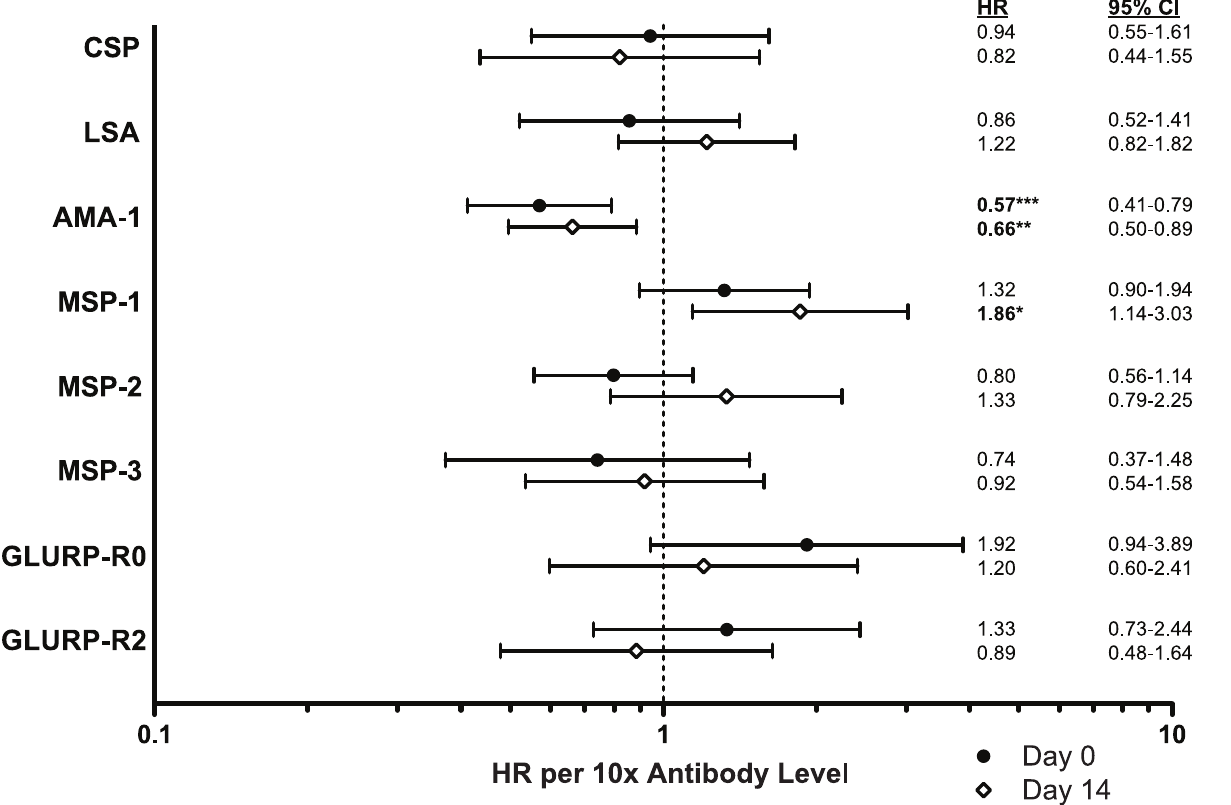
Figure 2. IgG responses and protection against treatment failure with amodiaquine + sulfadoxine-pyrimethamine (AQ + SP). Associations between IgG responses to 8 Plasmodium falciparum antigens and protection against treatment failure with AQ + SP were examined. Hazard ratios (HR), depicted by closed circles (Day 0, time of malaria treatment) or open diamonds (Day 14, 14 days following initiation of treatment), are expressed for every 10-fold increase in antibody level. Error bars indicate 95% confidence intervals (CI). Hazard ratios were evaluated using Cox proportional hazards, adjusting for parasite polymorphisms associated with treatment failure and subject age, with robust inference accounting for repeated measures in the same individual. Circumsporozoite protein (CSP); liver stage-antigen (LSA); apical membrane antigen 1 (AMA-1); merozoite surface protein 1, 2, or 3 (MSP-1, MSP-2, MSP-3); amino- or carboxy-terminal region of glutamine rich protein (GLURP-R0, GLURP-R2). *p , 0.05, **p # 0.01, ***p # 0.001.